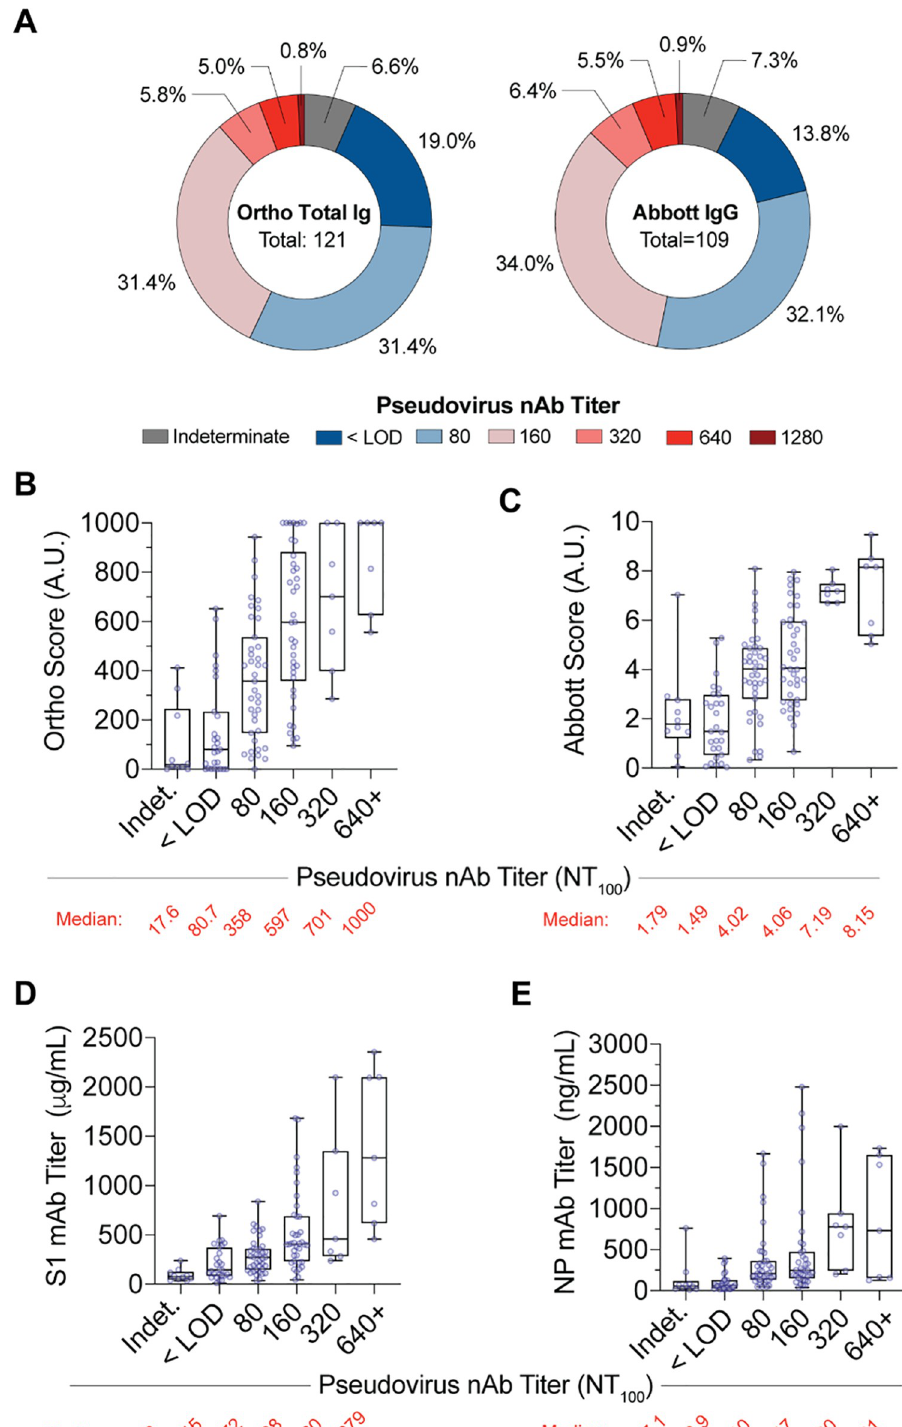
Fig 3. Correlation of NYC metro donor serological results with neutralization activity. A; Frequency of Ortho HTSA (left) or Abbott HTSA (right) seropositive donor pseudovirus neutralization end-point titers. B-E; Box plots of seropositive donor serology results using the Ortho HTSA, Abbott HTSA, S1 ELISA and NP ELISA for each category of neutralization end point titers. Boxes and whiskers denote 1 st and 3 rd quartiles and range, respectively. Median serology value of each category is shown below